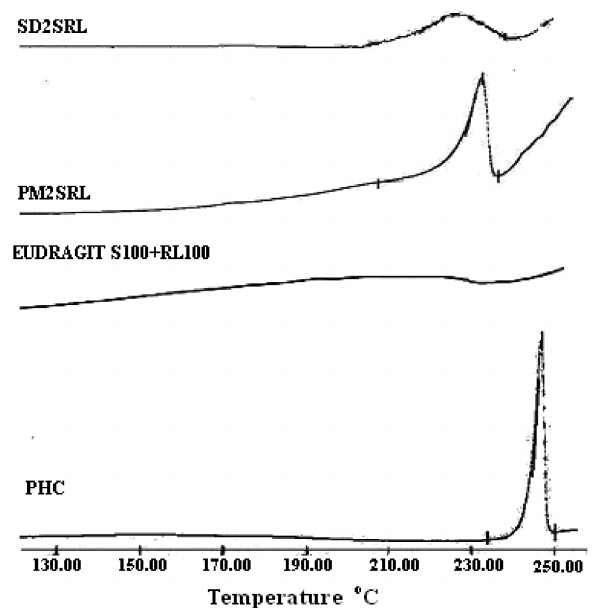
polymers, PM2SRL and 1 H NMR spectroscopy